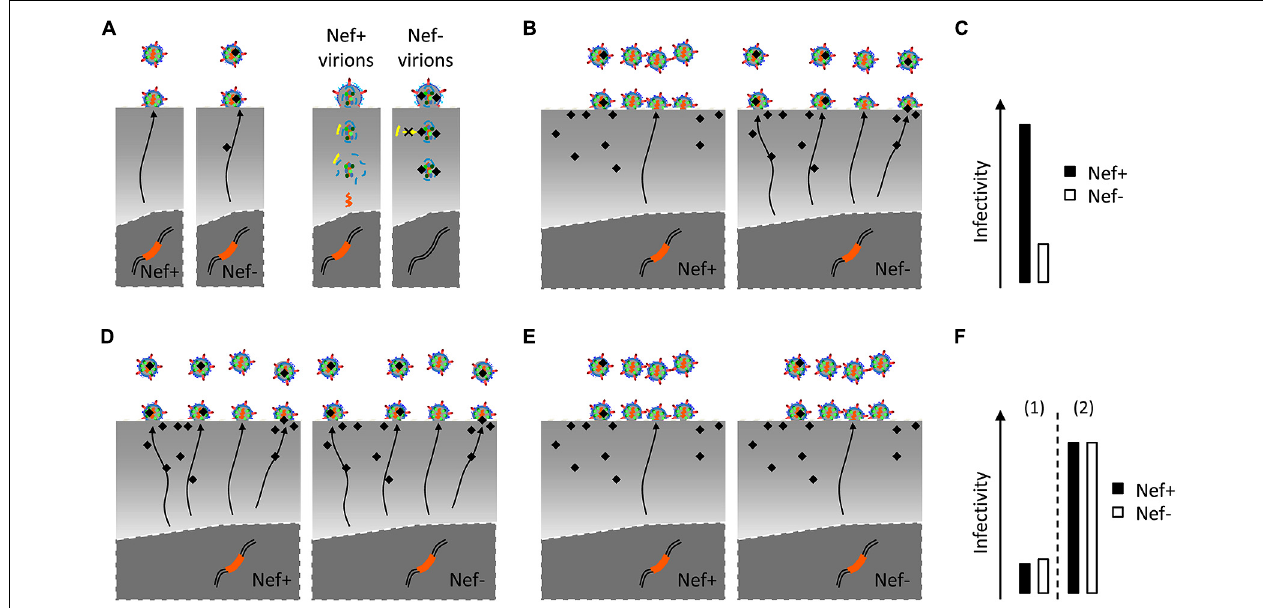
inhibitor or promote virus assembly to subcellular locations where the defect is not acquired (B) . (D–F) In contrast, Nef-non-responsive producer cells generate Nef + and Nef − viruses with similar infectivities (F) . Two possibilities may explain this phenotype: Nef fails to protect the virus from the defect [ D,F(1) , Virions have suboptimal infectivity even in the presence of Nef]; alternatively, producer cells lack the cause of the defect or target virus assembly away from inhibitors [ E,F(2) , Nef- virus already has optimal